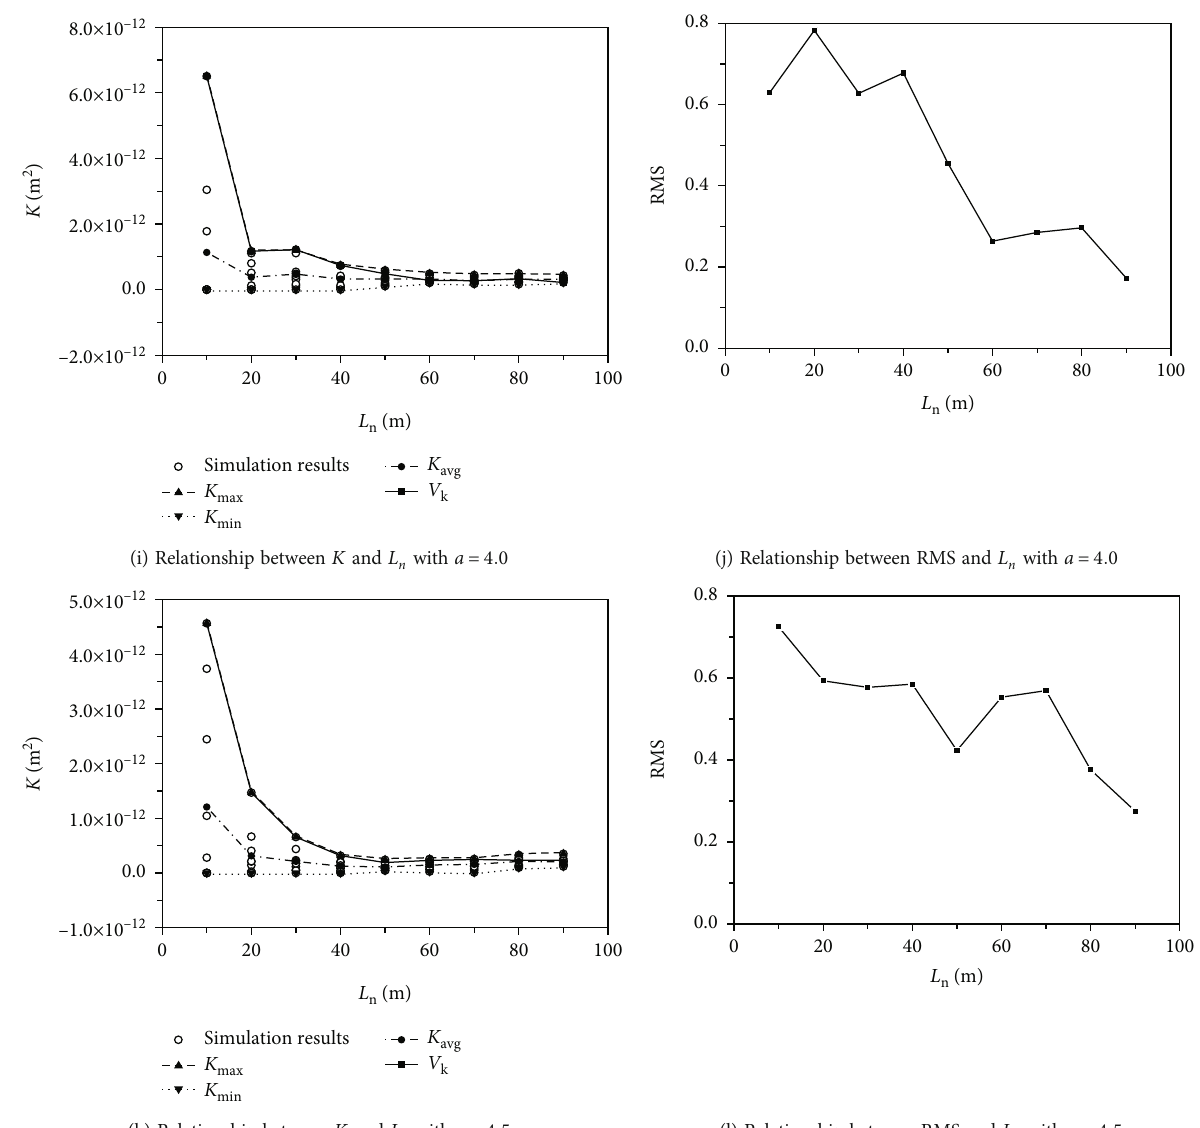
Figure 11: Variations in K and RMS with di ff erent a in cube